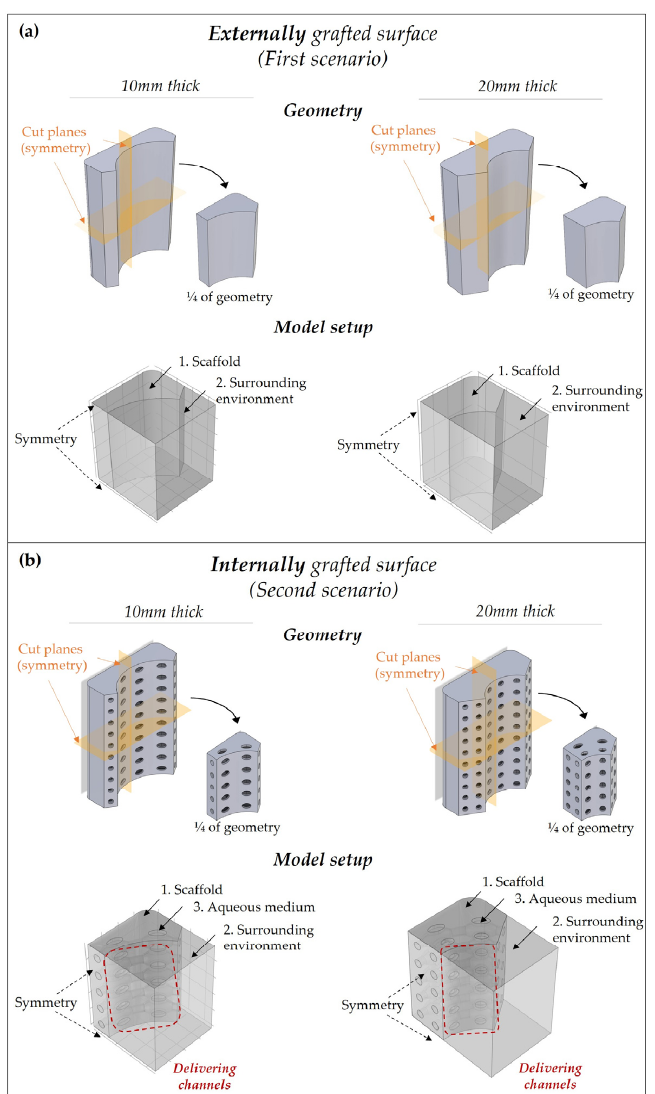
Figure 2. Model implantation on a 3D complex scaffold in the two different scenarios: ( a ) externally grafted and ( b ) internally grafted with ICOS-Fc. Geometry: due to the presence of two mid-planes, 1/4 of the geometry was investigated. Model setup—domains: (1) polyester-based scaffold, (2) surrounding environment (i.e., periosteum); and (3) aqueous medium within the macro- porous architecture. Boundary conditions: symmetry conditions were placed on the mid-plane cutting surfaces; the concentration boundary was placed on the interface between each domain as a continuity condition; and in the second scenario, no flux conditions were set on the channel surfaces except for those open for